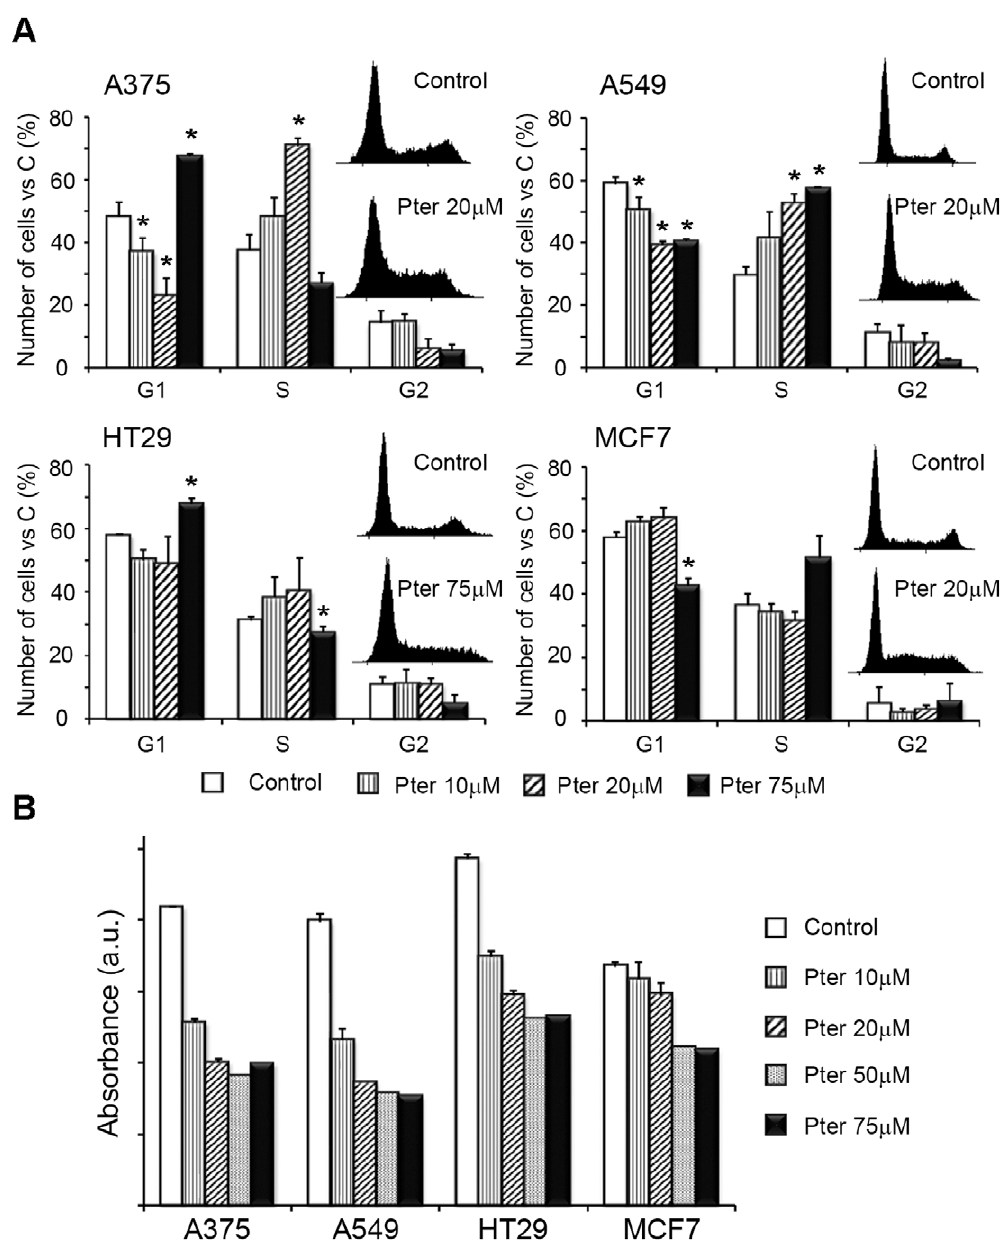
Figure 2. Effect of pterostilbene on cell cycle distribution and DNA synthesis. A) Tumor cells were seeded in six well-plates and treated 24 h later with indicated concentrations of Pter. After 24 h, cells were fixed and stained with propidium iodide as explained under material and methods. The DNA content of the cells was analyzed by flow cytometry (10,000 cell events were collected per sample). Representative cell cycle histograms for Control and Pter-treated cells are shown. Results are expressed as % of total cells 6 SD (n=3) (*p , 0.05 Vs. Control). B) DNA synthesis was evaluated by BrdU incorporation after 4 h of incubation with Pter followed by 2 h with Pter and 10 m M BrdU.